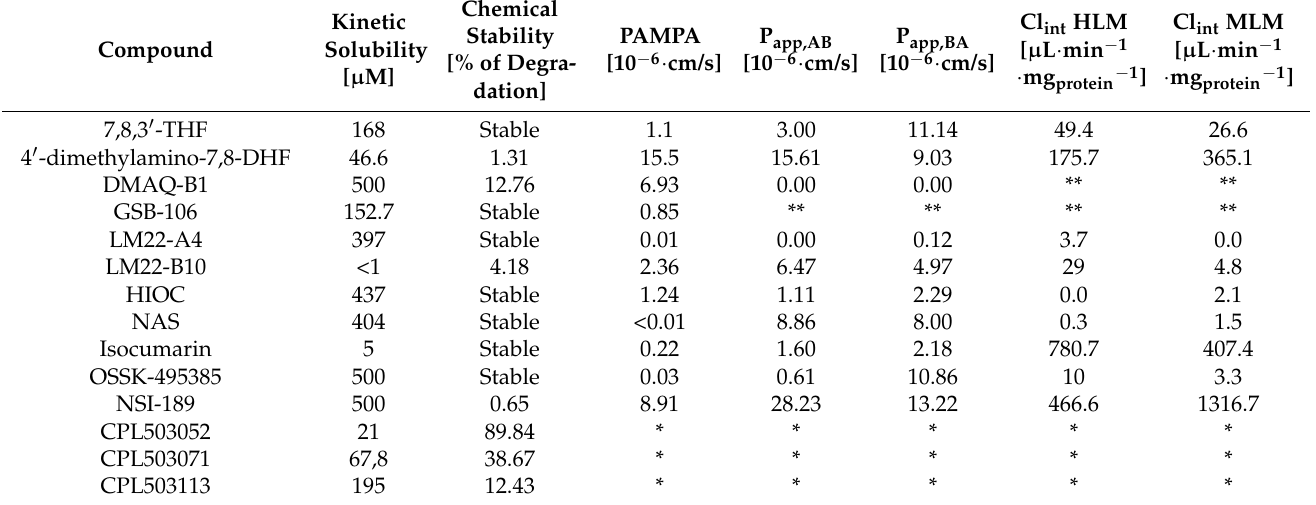
Table 2. Results of performed physiochemical and ADME analyses. Kinetic solubility was determined in terms of µ M concentration. Chemical stability data (pH = 7.4) are presented as % of compound degradation of initial compound concentration in the analyzed sample. Results of parallel artificial membrane permeability assay (PAMPA) are expressed as 10 − 6 cm/s of compound permeability through biomembrane. Results of passive permeability through the Caco-2 monolayer are given as apparent permeability (P app ) from apical to basal compartment (AB) or in the opposite direction (BA). Metabolic stability is given as intrinsic clearance (Cl int ) in human (HLM) and mouse (MLM) liver microsomes per time per amount of microsomal protein.